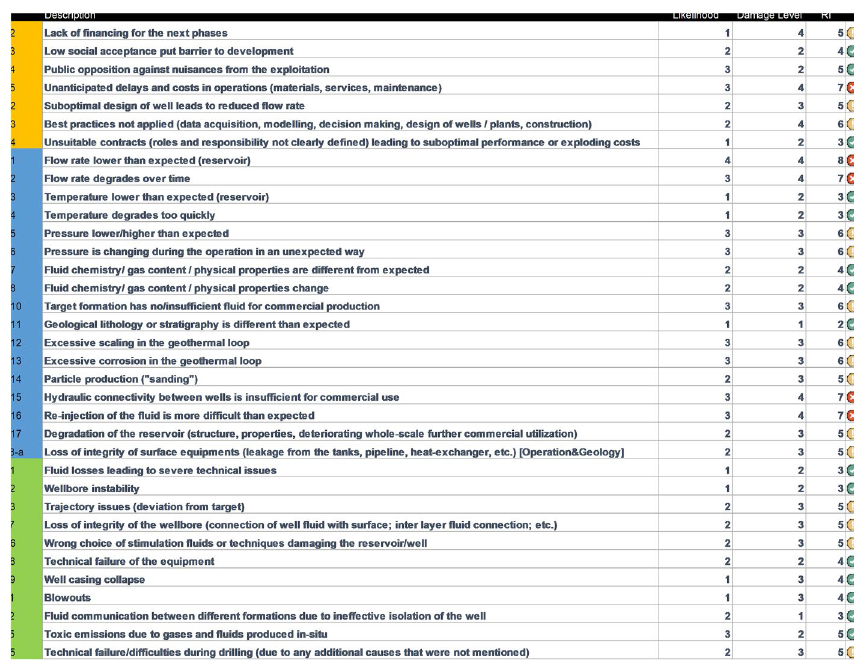
(yellow: managerial and socio-economic risks, blue: operation and geology risks and green: drilling risks)